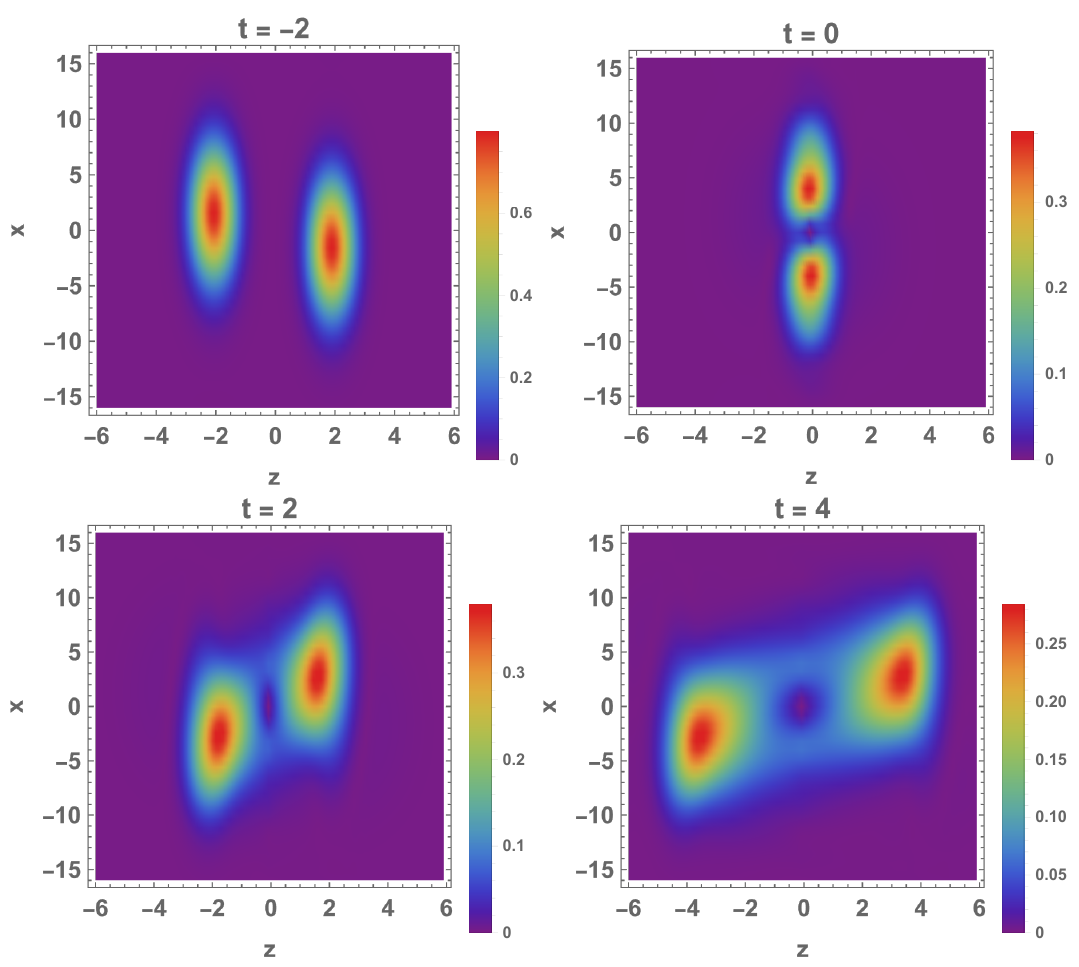
Figure 9 . The energy flux | T 0 i | including first order corrections in transverse derivatives, for times t = − 2 , t = 0 , t = 2 and t = 4 (from top left to bottom right), and at y = 0 . O ( (cid:15) 2 ) -corrections again substantially improves agreement in the central region z = 0